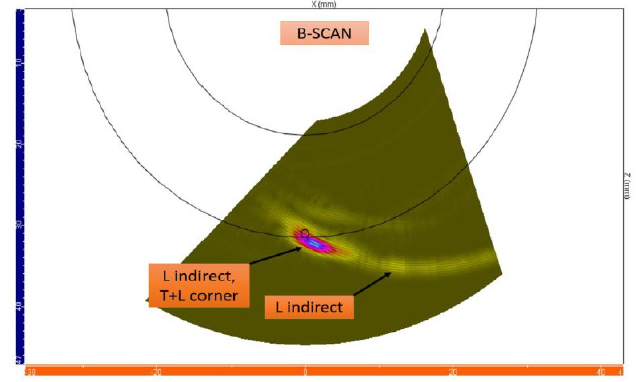
Fig. 10. Identified echoes: 1 mm SDH at back wall.